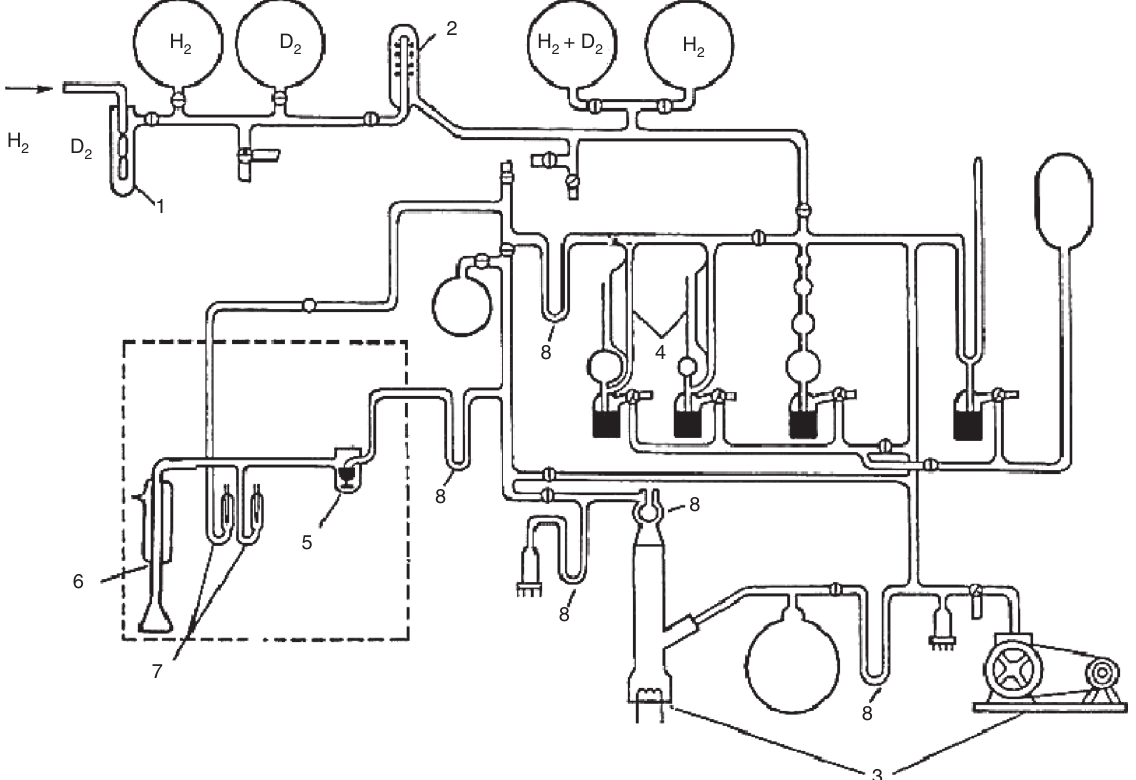
Figure 1 Scheme of the equipment for the catalytic studies: 1 – Petryanov filter (FP ™ ), 2 – palladium membrane, 3 – backing vacuum (rotary vane pump) and oil diffusion pumps, 4 – two glass McLeod gauge designed for two pressure ranges, 5 – gallium gate, 6 – reactor with a vacuum jacket, 7 – conductivity cells, 8 – liquid nitrogen trap; dotted – entire reaction volume, which is heated at vacuum pumping up